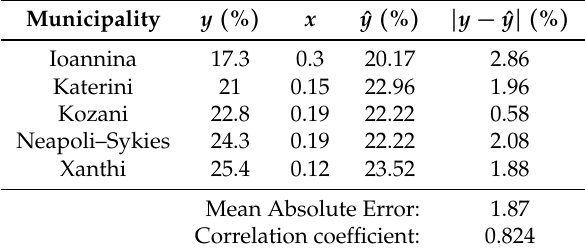
Table 5. Results in a held-out set of municipalities that were not used for the construction of our